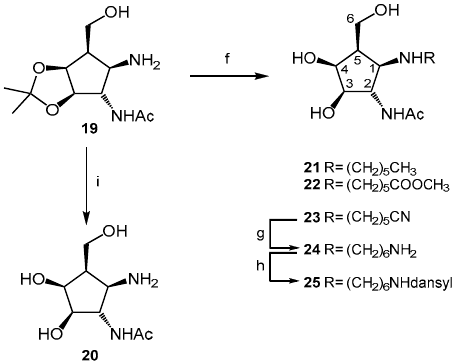
Figure 2. Crystal stuctures of alcohol 14 (CCDC 1826202) and acetamide 18 (CCDC 1826203). From tricycle 18 , by hydrogenolysis over Perlman’s catalyst, cyclopentane 19 featuring a free amine was obtained in good yield. Subsequent acidic deprotection yielded free aminotriol 20 (Scheme 2).